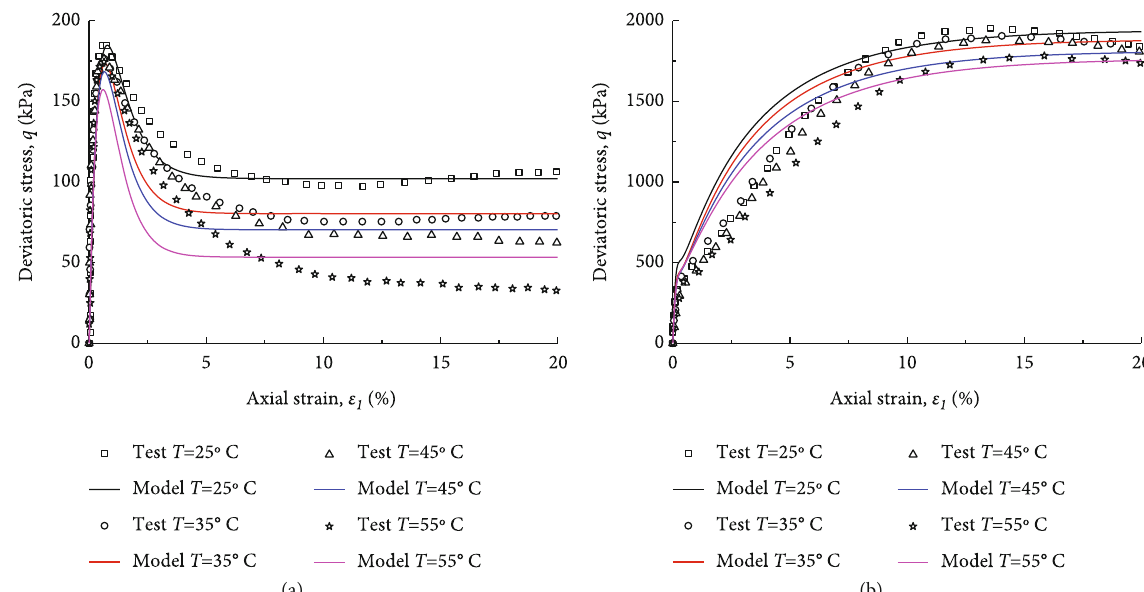
Figure 3: Simulation of undrained shear stress-strain relationships of saturated sand with di ff erent relative density at di ff erent temperatures = 20 %; (b) D = 70 % (test data after Liu [43]). ( p ′ = 400 kPa, u = 300 kPa): (a) D r r